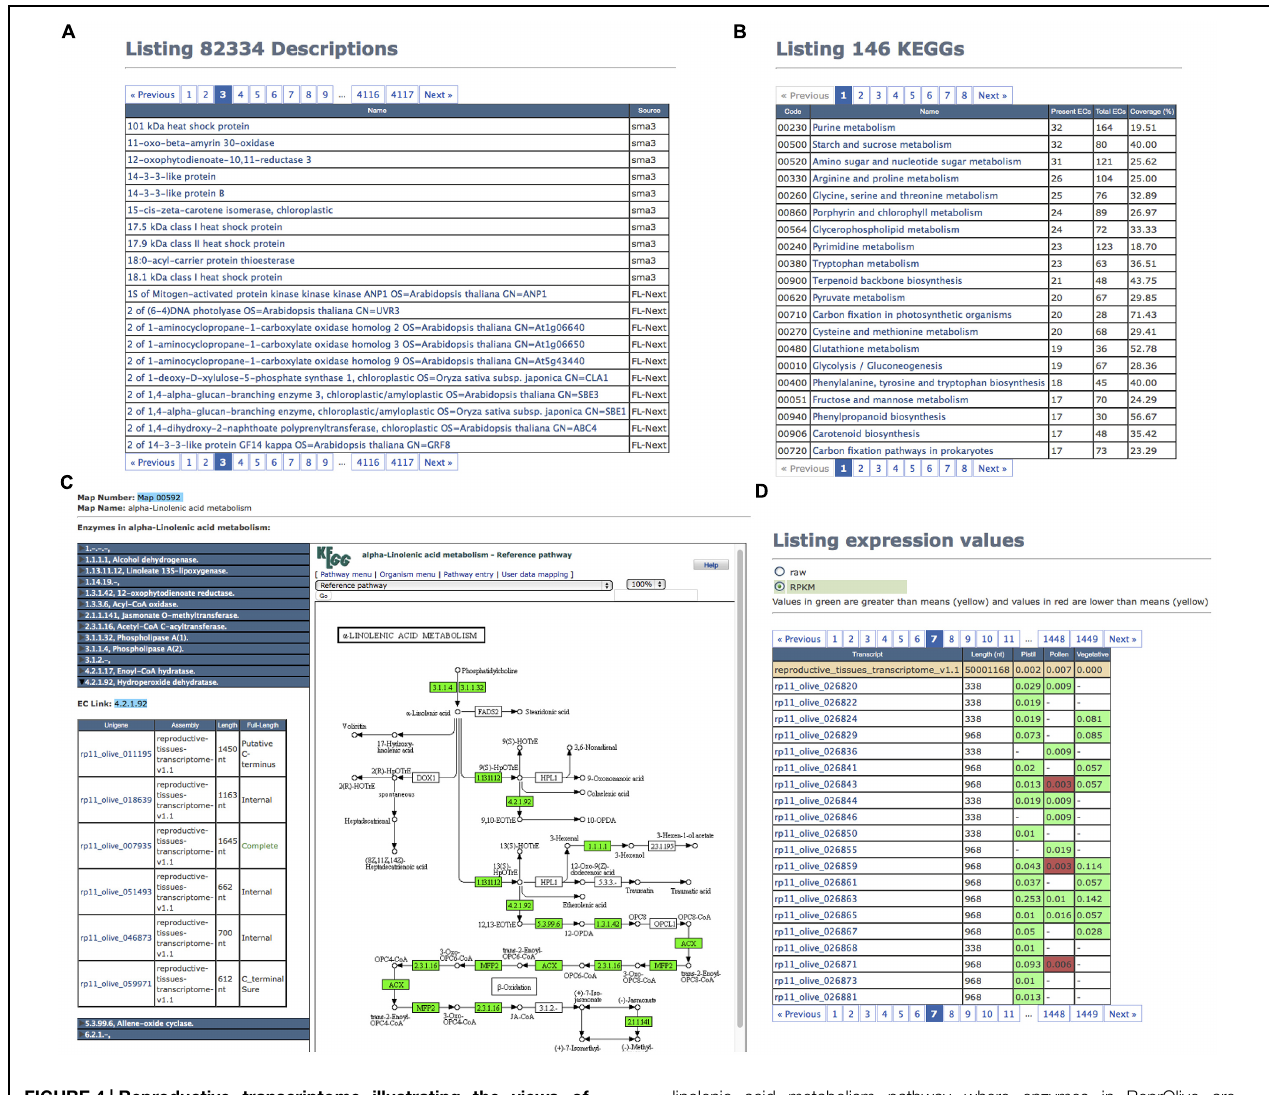
FIGURE 4 | Reproductive transcriptome illustrating the views of Description, KEGG Pathways, and Expression tab panels. (A) List of TT description that illustrates the lack of consistence between descriptions provided by humans. (B) First page of KEGG Pathways showing the most populated ones in ReprOlive. (C) Example of